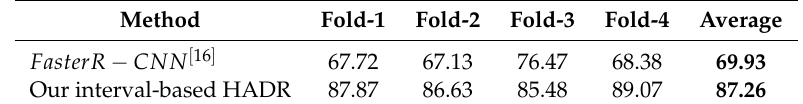
Table 2. The mean average precision (mAP) (%) of the two methods.